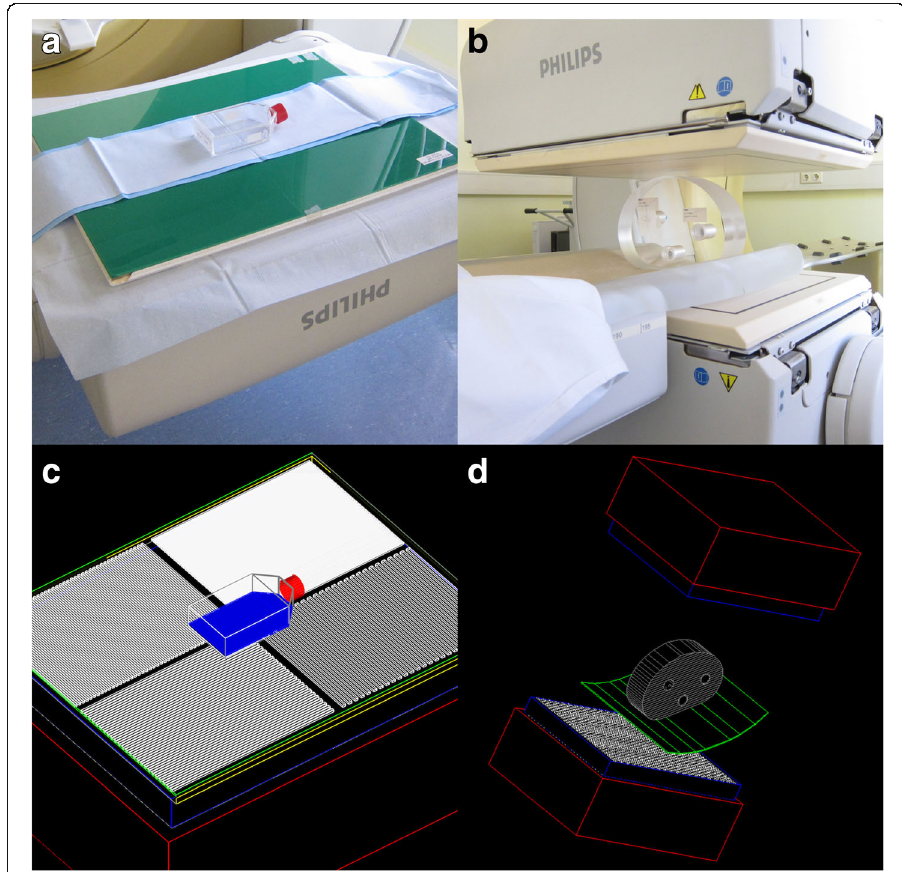
Fig. 2 Setup. Measurement setups and corresponding simulated geometries. a , c Planar setup. b , d Tomographic